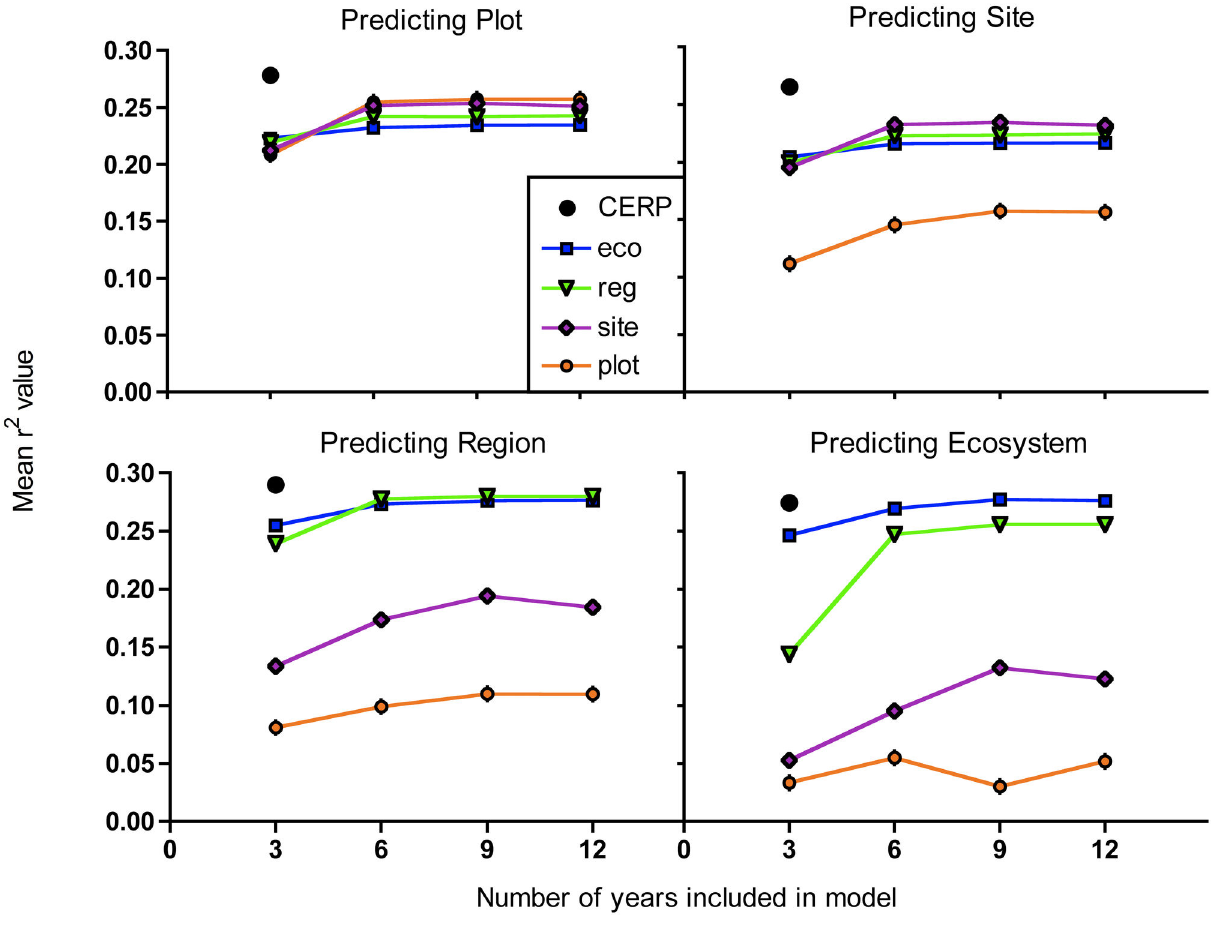
Figure 3. Mean r 2 values of contiguous year models when predicting different spatial scales. Values are averaged across all groups of years that were predicted in order to make trends easier to extract visually. The corresponding non-contiguous figures can be found on the online supplement. Error bars are present, but are so small they are not visible. Details of the unpooled groups follow the same trends and can be seen in figures S1 and